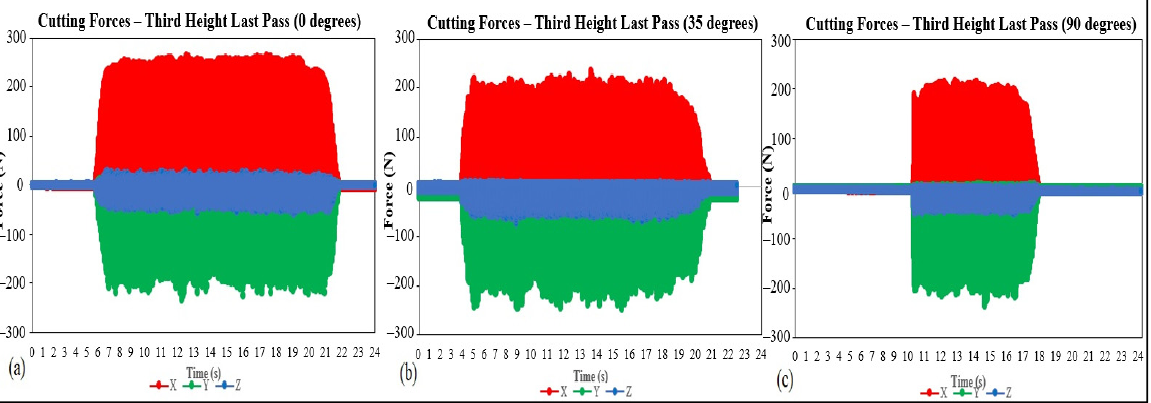
Figure 10. Cutting forces measurements for the last machining pass, ( a ) 0 degrees, ( b ) 35 degrees, and ( c ) 90 degrees of cutting angle.